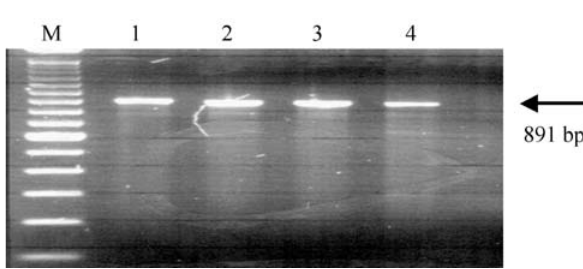
Figure 1 - GH genomic amplicons separated by 1.5% agarose gel electro- phoresis. Lane M: 100-bp DNA molecular weight markers; Lane 1: PCR product using 1.5 mM MgCl 2 ; Lane 2: PCR product using 2.0 mM MgCl 2